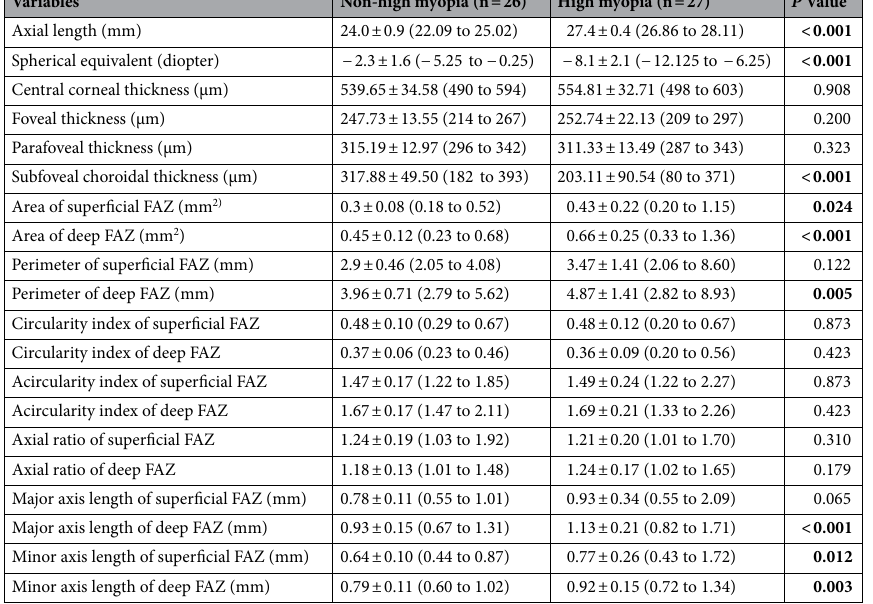
Table 2. Ocular factors and FAZ parameters of OCTA in non-high myopia (lower quartile) and high myopia (upper quartile) groups. FAZ foveal avascular zone. Factors with statistical significance are shown in boldface.